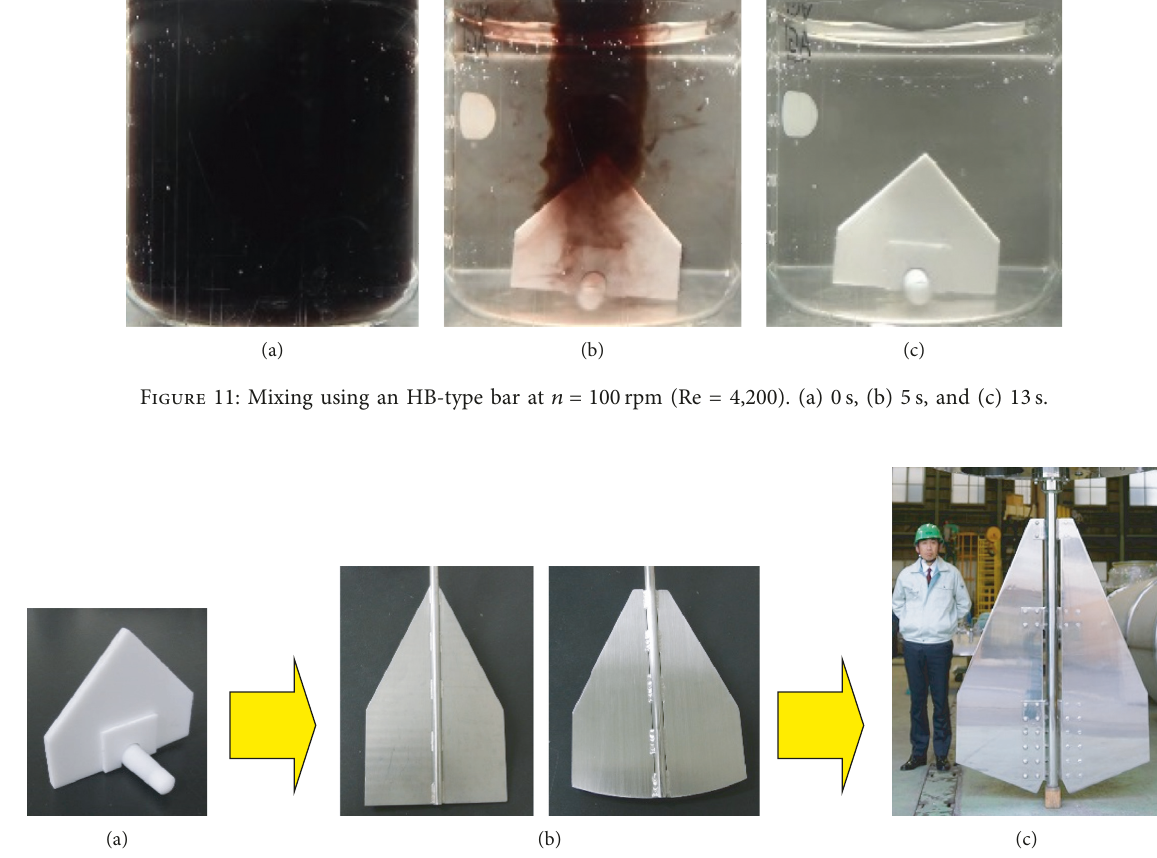
Figure 12: Scale-up system of the HB impeller. (a) Laboratory scale (500 mL), (b) pilot scale (5L), and (c) Industrial scale (4m 3